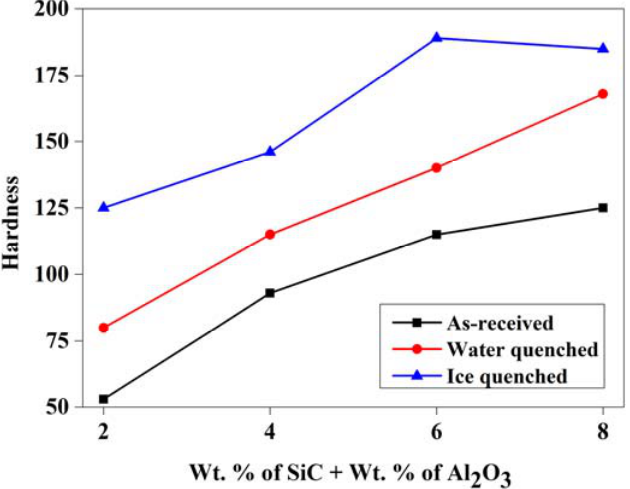
Figure 6: Vickers hardness with varying content of SiC and Al 2 O 3